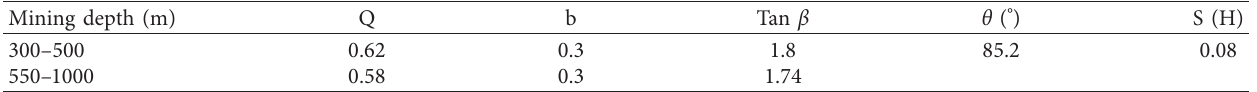
Table 2: Predicted parameters of PIM in the case of the first mining.